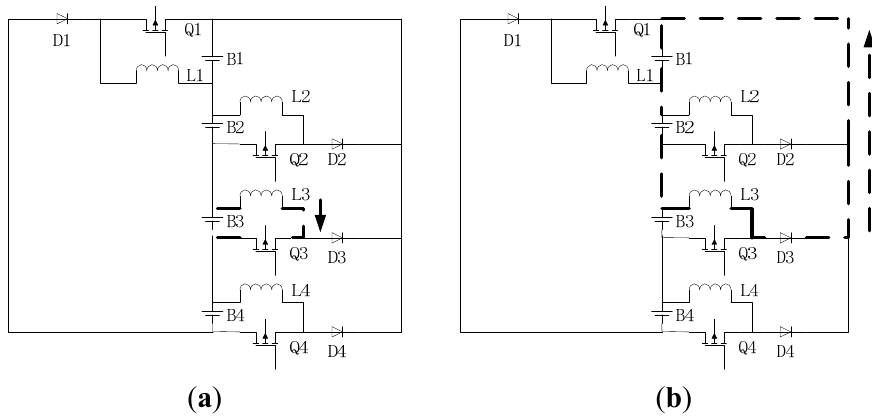
to B : ( a ) When Q (cid:2870) (cid:2869) is switched off, current flows from L (cid:2870)